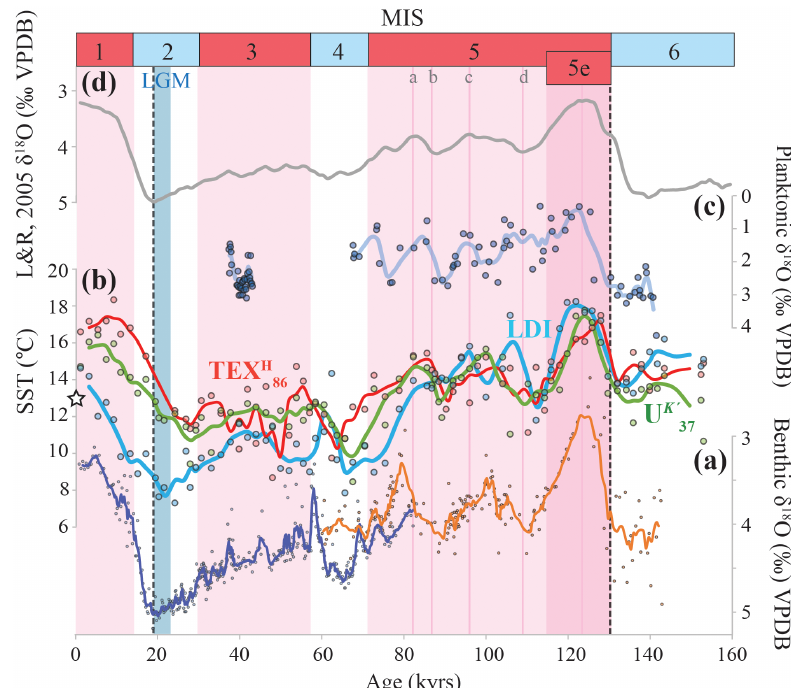
Figure 5. Foraminiferal oxygen isotope and organic temperature proxy records for ODP 1234. (a) The benthic stable oxygen isotope records for ODP Site 1234 of Heusser et al. (2006), in which the blue data reflect the benthic δ 18 O dated by correlation with Atlantic core MD95204, and the orange data represent the δ 18 O data correlated with the Vostok ice core chronology. (b) The organic geochemical seawater surface (cid:48) temperature records: U K (green), TEX H (red), and LDI (blue). The thick lines reflect 3-point running averages. (c) Planktonic foraminiferal 37 86 δ 18 O of the species Globigerina bulloides with the 3-point running average. (d) Global compilation of benthic stable oxygen isotopes (Lisiecki and Raymo, 2005). The pink colored bands reflect the interglacial periods (MIS 1, 3, and 5). The pink lines within MIS 5 reflect the different substage δ 18 O minima and maxima. MIS (substage) ages are according to Lisiecki and Raymo (2005). The blue band reflects the Last Glacial Maximum, and the star symbol represents the present-day SST (World Ocean Atlas 2013 version 2). The dashed lines indicate the onset ages of Terminations 1 (Pacific age of Stern and Lisiecki, 2014) and 2 (approximate age).